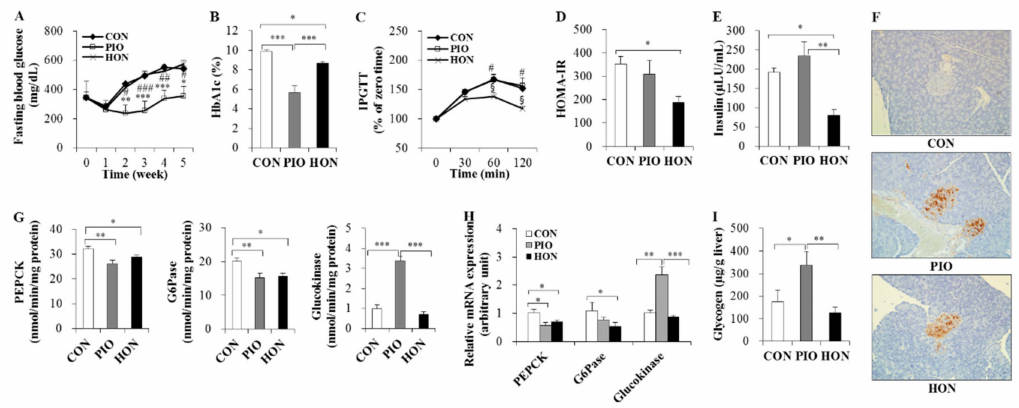
Figure 2. E ff ect of dietary HON on fasting blood glucose levels ( A ), blood HbA1c levels ( B ), IPGTT ( C ), HOMA-IR ( D ), plasma insulin levels ( E ), immunohistochemistry with anti-insulin ( F ), the activity and mRNA expression of hepatic glucose-regulating enzymes ( G , H ), and hepatic glycogen content ( I ) in db / db mice. Male C57BL / KsJ- db / db mice were fed a normal diet with or without HON (0.02%, w / w ) or PIO (0.01%, w / w ) for 5 weeks ( n = 10 per group). ( A , C ): Data are presented as mean ± SE. CON vs.